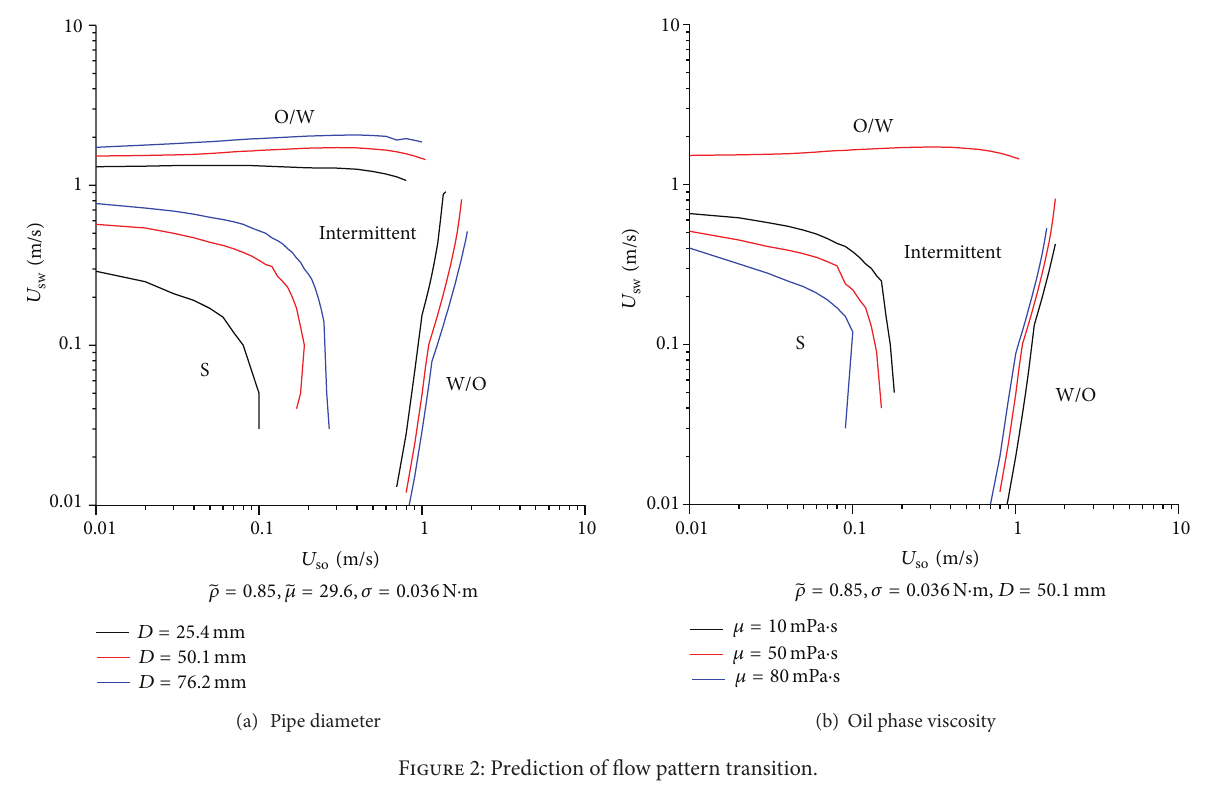
Figure 2: Prediction of flow pattern transition.